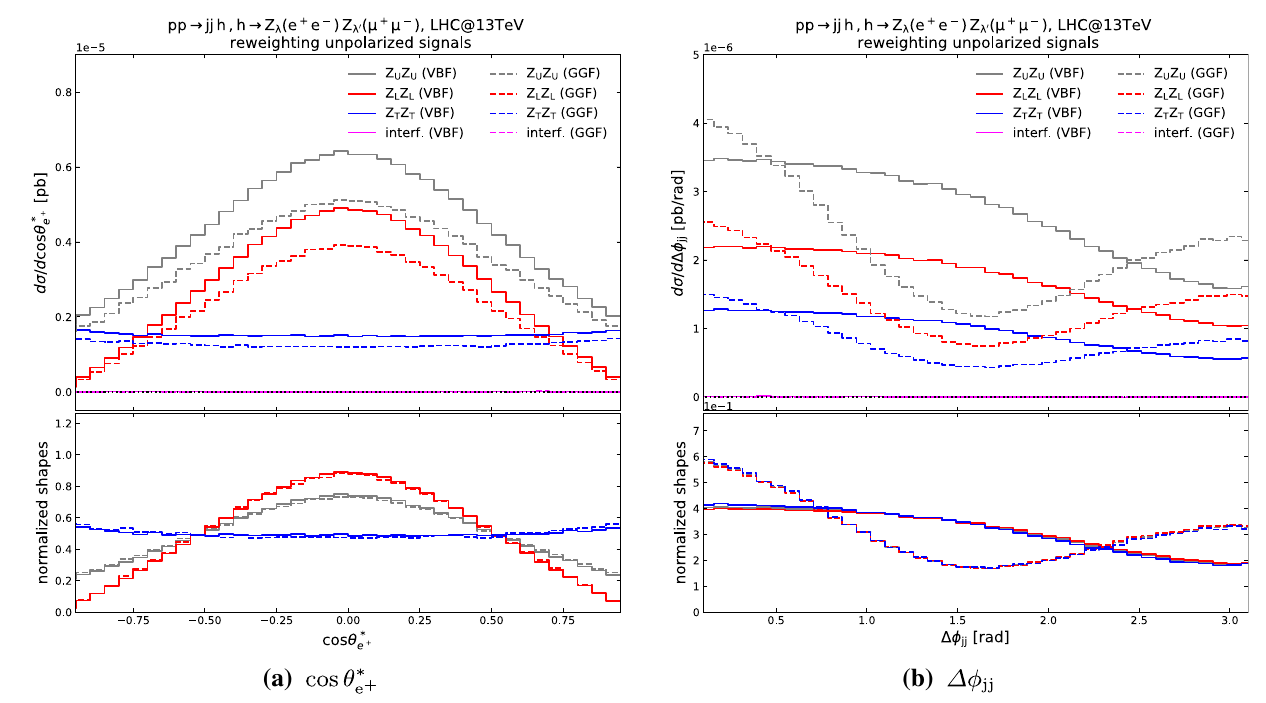
Fig. 3 Distributions for Higgs production in GGF (dashed curves) and VBF (solid curves) at the LHC@13TeV: cosine of the positron decay angle in the corresponding Z boson rest frame ( a ) and azimuthal differ- encebetweenthetwojets( b ).PolarizedVBF(GGF)curvesareobtained